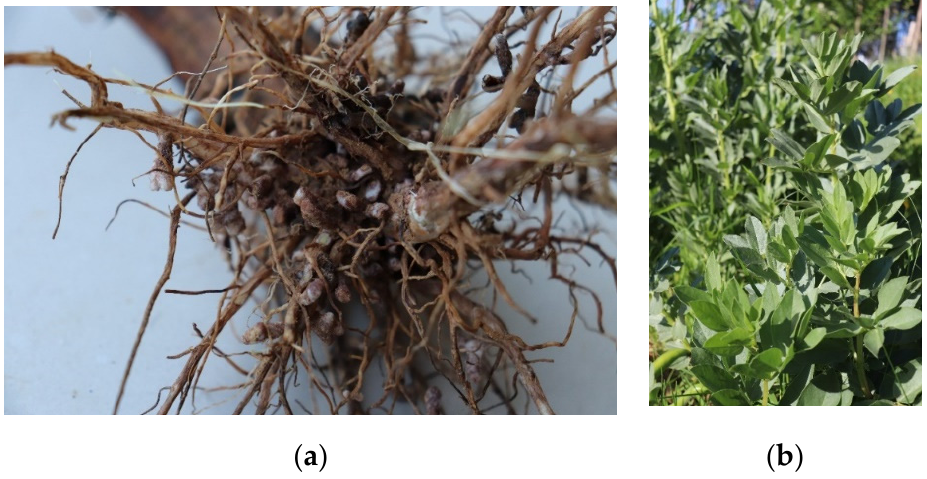
Figure 10. Nodules of N incorporated in broad bean roots (photos taken in April 2020 of broad beans sown in the Low Mondego area): nodules of N in broad bean roots ( a ) and broad bean leaves ( b ). The values for the biological fixation in crop land ( BNF a ) are computed based on the areas of leguminous plants in the Low Mondego. The crops considered are beans, chickpeas, broad beans, and peas. The cultivation areas are given by INE-NAC and INE-AS [27] databases. The biological N fixation coefficient of each crop is based on [24]. Figure 11a includes the total areas of these crops for all time periods and for all sub-basins. The areas with leguminous plants have been decreasing considerably since the first period under analysis (1986–1989). In the 1980s and early 1990s, the Arunca sub-basin (SB6) had by far the largest area of leguminous plants, but it was reduced, until 2018, to areas similar to those practiced in SB3 (the Anç ã sub-basin). In fact, it seems that most of these crops are mainly grown by subsistence farmers to meet their family needs. According to [43], one of the main drivers for giving up farming at the turn of the millennium was related to the aging of the farmers who gave up and had no younger successors to maintain the